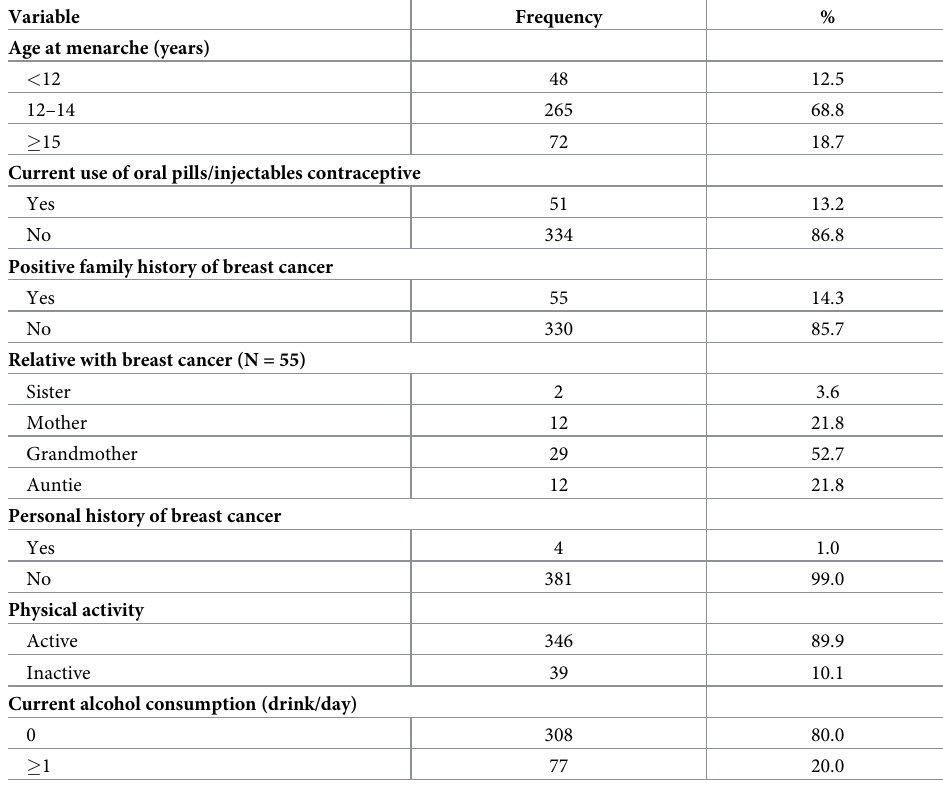
Table 4. Selected breast cancer risk